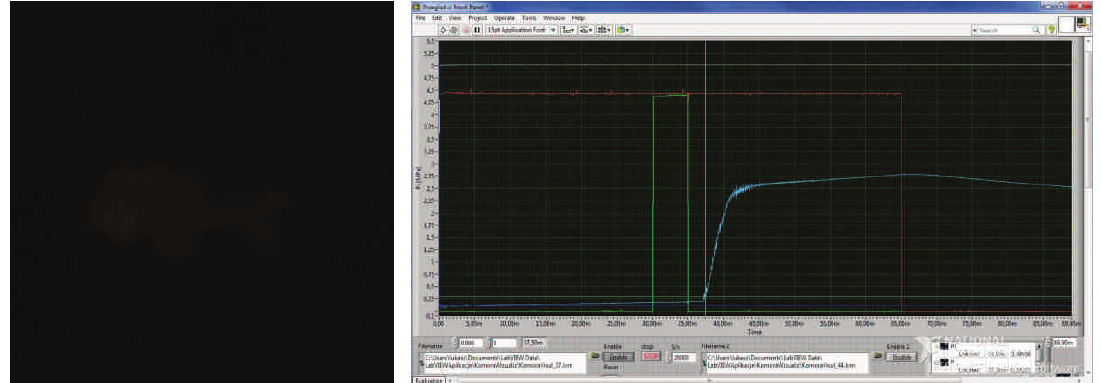
Fig. 4a. Photo of combustion advancement and pressure course with marked pressure value 2.5 ms after combustion initiation. Combustion initiation – 35 ms after opening of injector